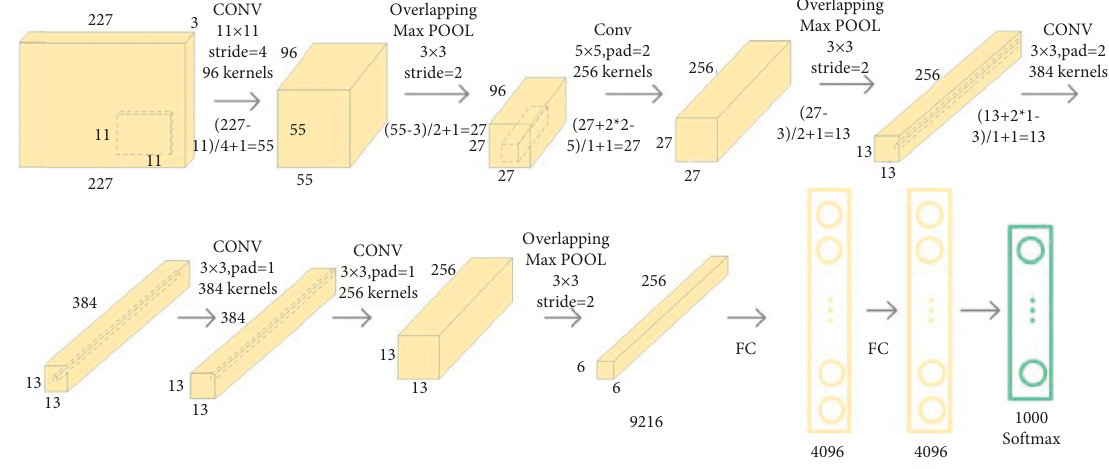
Figure 3: Specific structure of the AlexNet neural